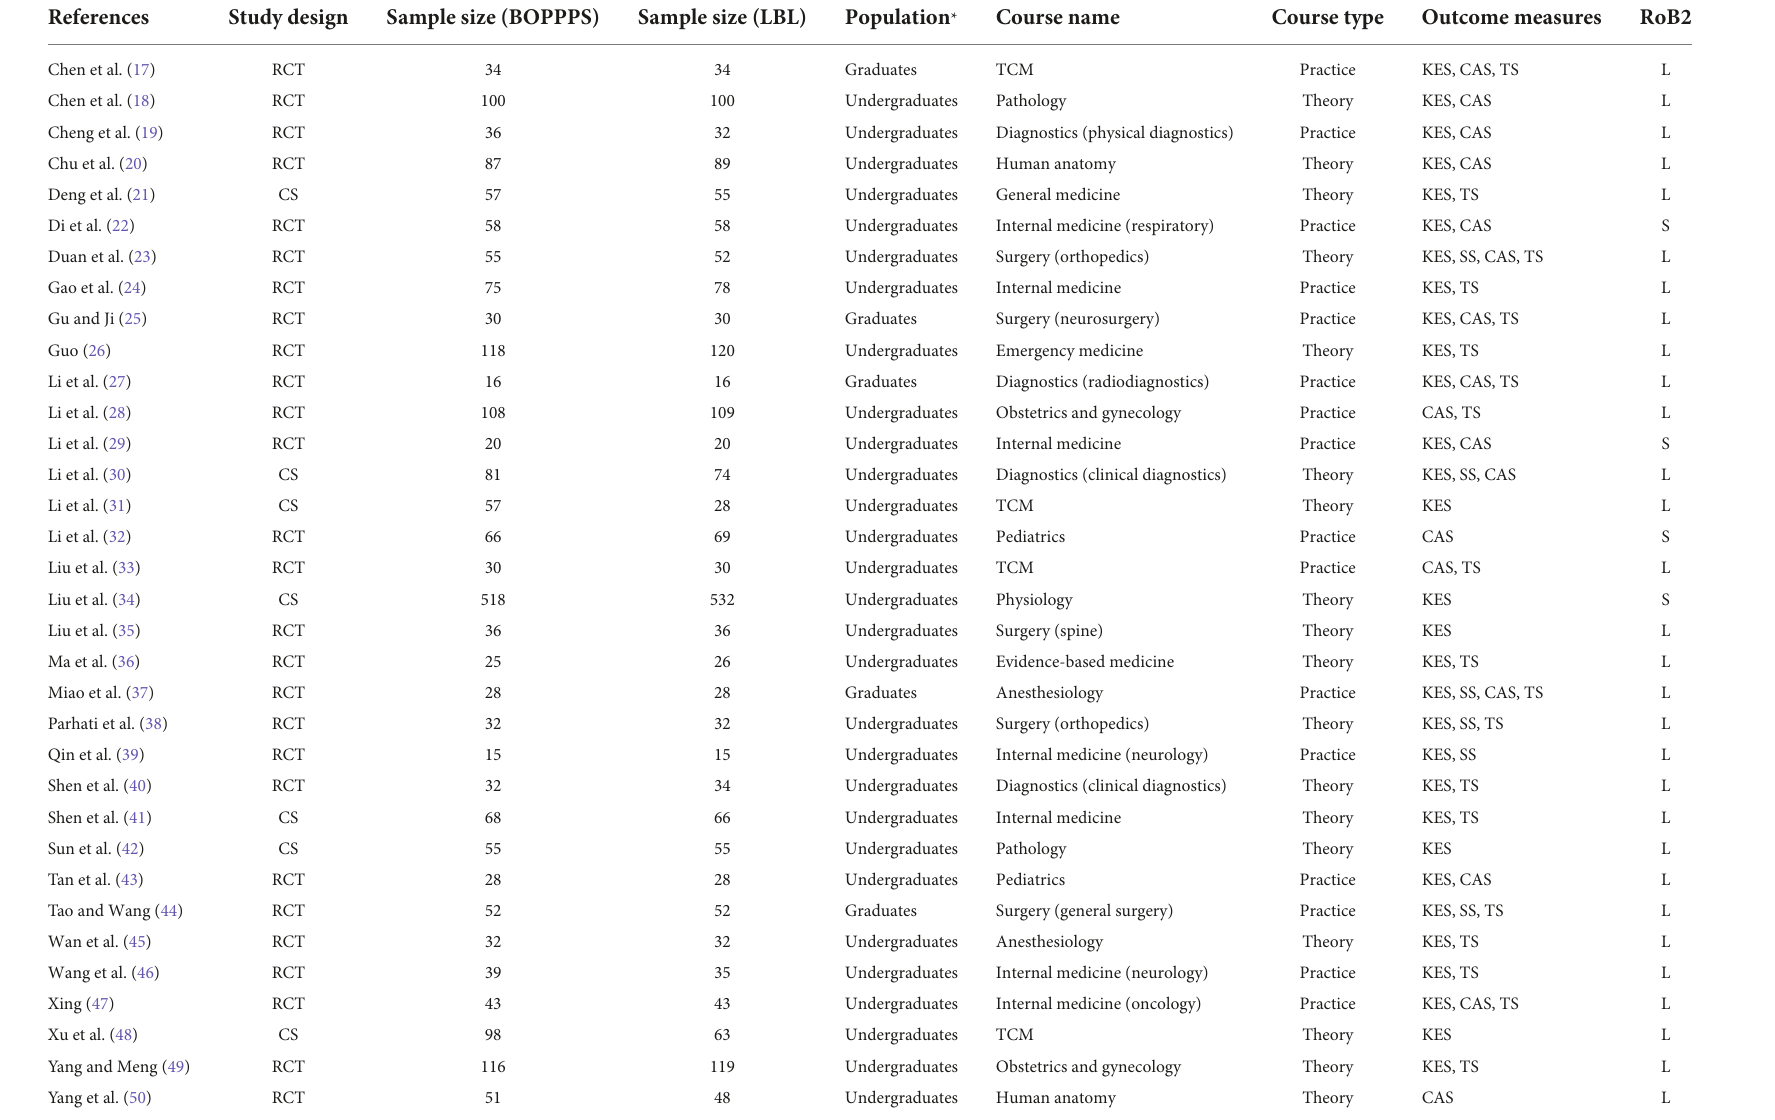
TABLE 1 Main characteristics of the included studies in the current